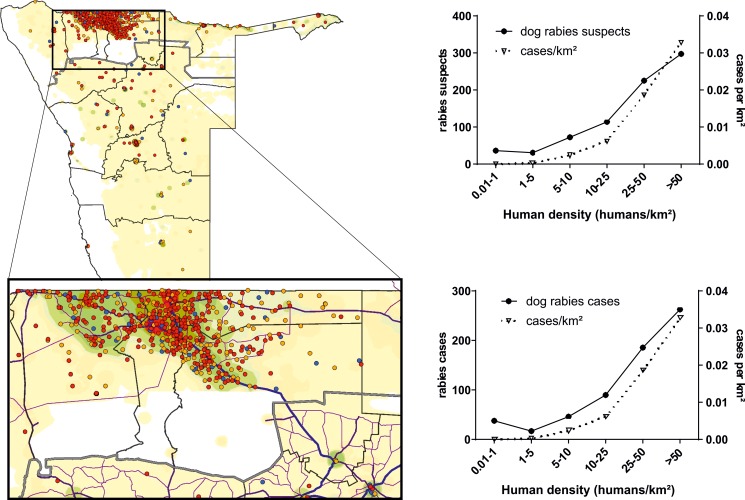
Rabies surveillance in dogs: Rabies cases (red dots), reported rabies suspects (orange dots) and dog samples tested negative (blue dots).The vast majority of rabies cases in dogs were reported from the NCAs north of the veterinary fence (n = 600), while in the remaining part of Namibia only 44 cases were confirmed. The underlying shading represents the relative human population density with darker colors indicating a higher density. Below: Enlargement of the area in the NCAs with the highest numbers of rabies cases. Main roads (blue, pink) are indicated. To the right: charts showing the absolute number of rabies cases or rabies suspects per density class (left y-axis) and the density of rabies cases or rabies suspects per km² per respective density class (right y-axis).